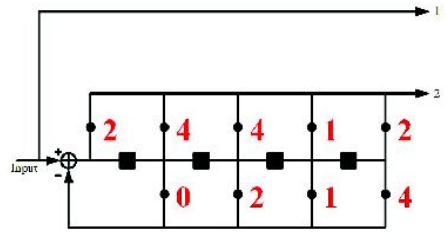
Figure 10. 5-ary, constraint length = 5,